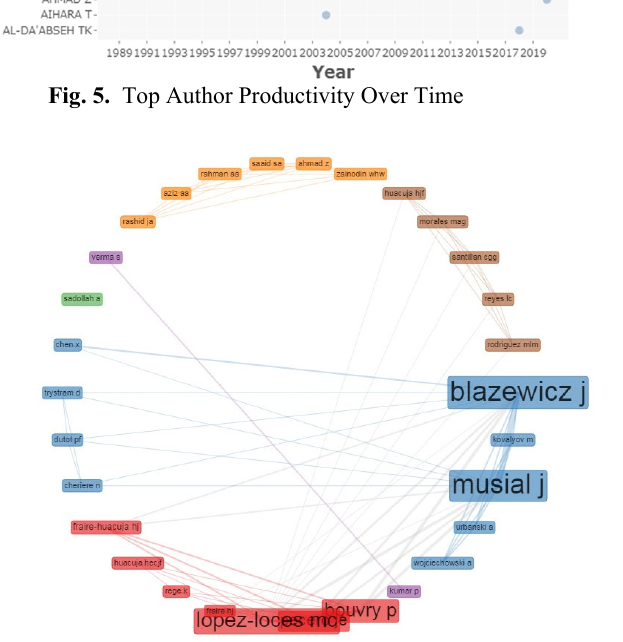
Fig. 6. Collaboration Among the 30 most Productive